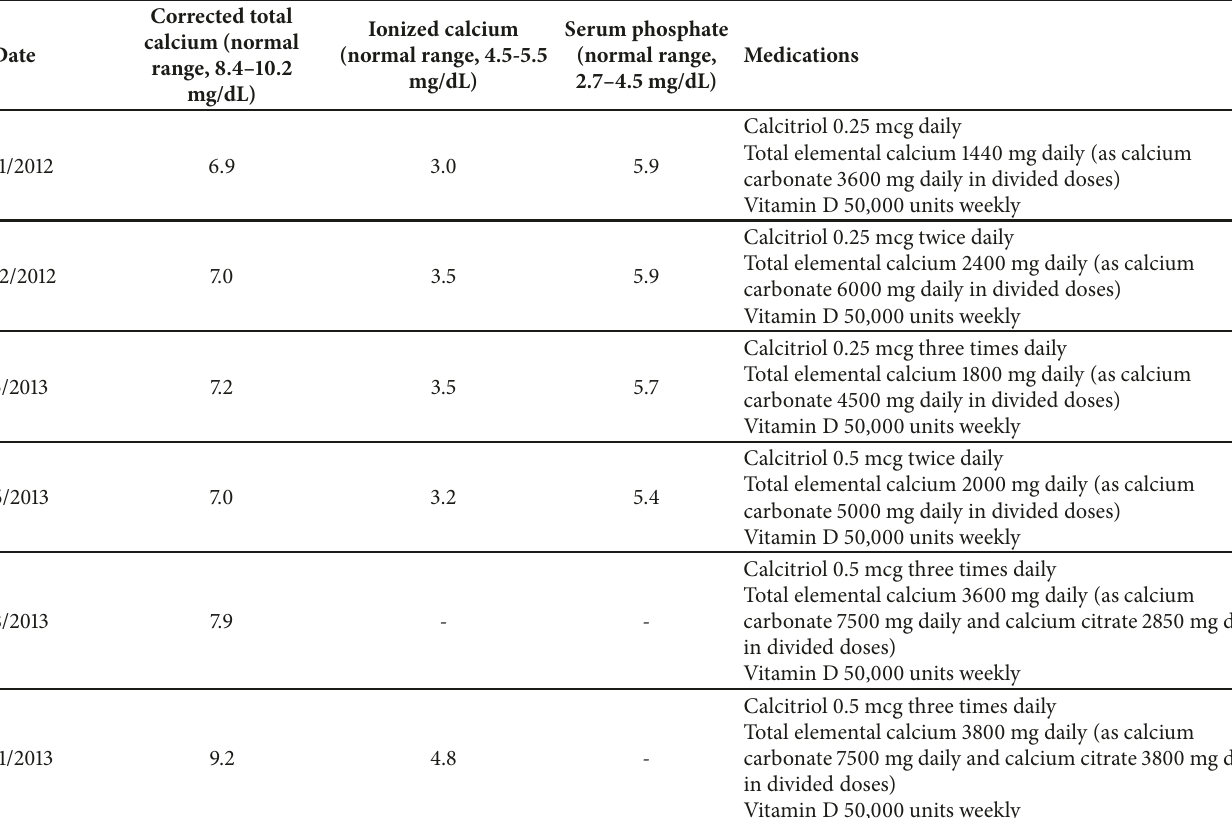
Table 1: Clinical course showing laboratory studies and treatment